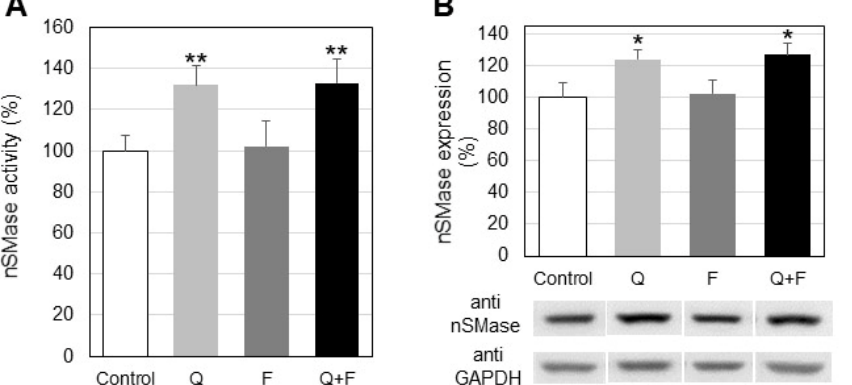
Figure 3. Changes in the activity ( A ) and protein expression ( B ) of neutral sphingomyelinase (nSMase) in control and treated with quercetin (Q) and fingolimod (F) HepG2 cells. Values are expressed as % of controls (100%). Representative images from Western blot analysis with specific antibodies to neutral sphingomyelinase (anti-nSMase) are shown at the lowermost of panel B. Reaction with anti-glyceraldehyde-3-phosphate dehydrogenase antibodies (anti-GAPDH) was used as an internal control for loading. Values are means ± SD. Statistical significance is presented as comparison of treated cells with controls. * p < 0.05; ** p < 0.01.